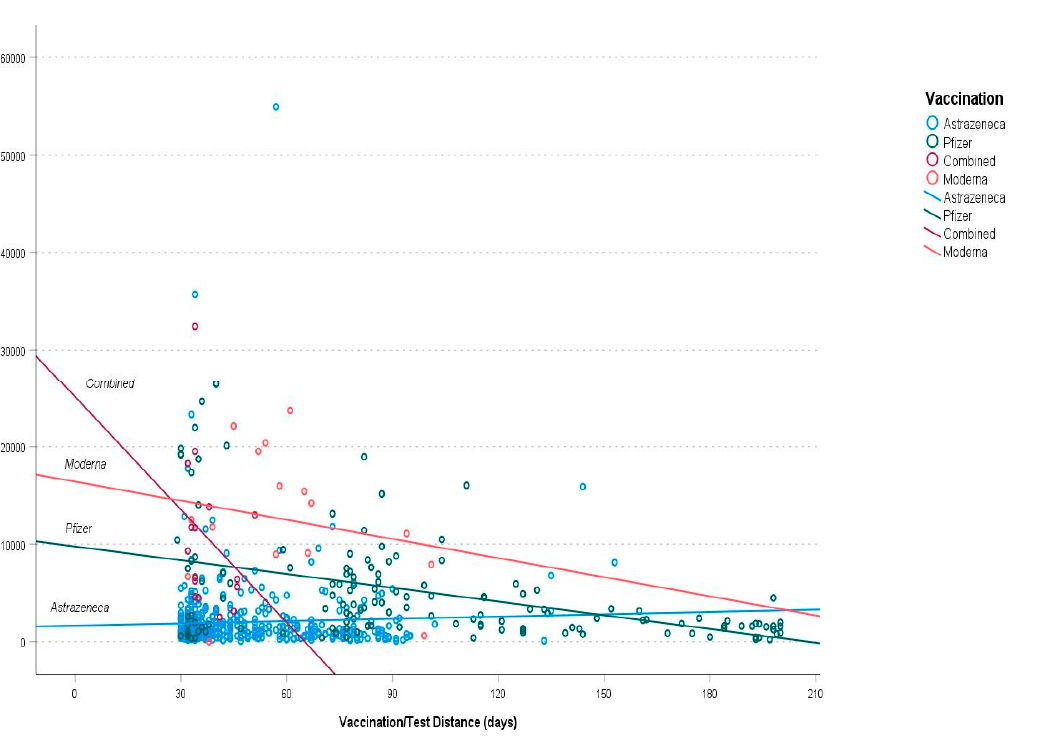
Figure 1. Antibody titer decreasing over time. Purple represents Combined Vaccination, red Moderna, green Pfizer and blue Astrazeneca .